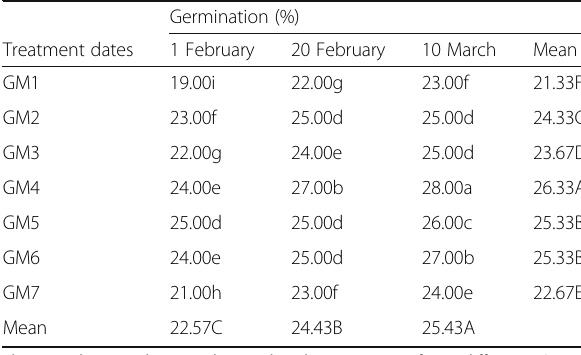
Table 2 Effect of planting dates and different growing